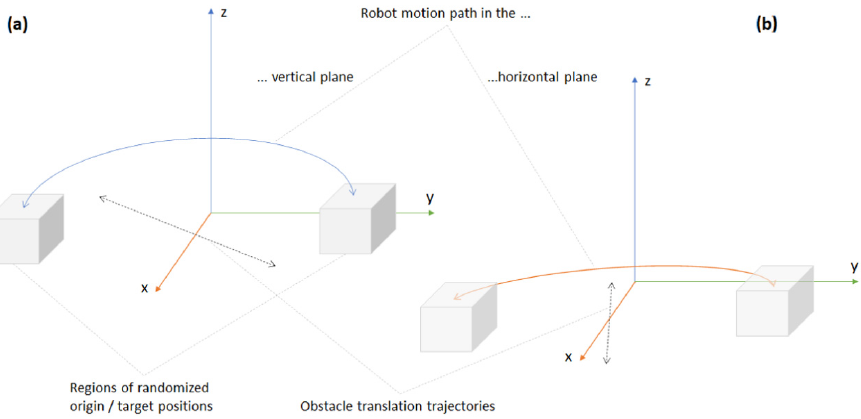
Figure 13. Sketch of the test configurations with dynamic obstacle avoidance in the ( a ) vertical and ( b ) horizontal planes. ( b ) horizontal